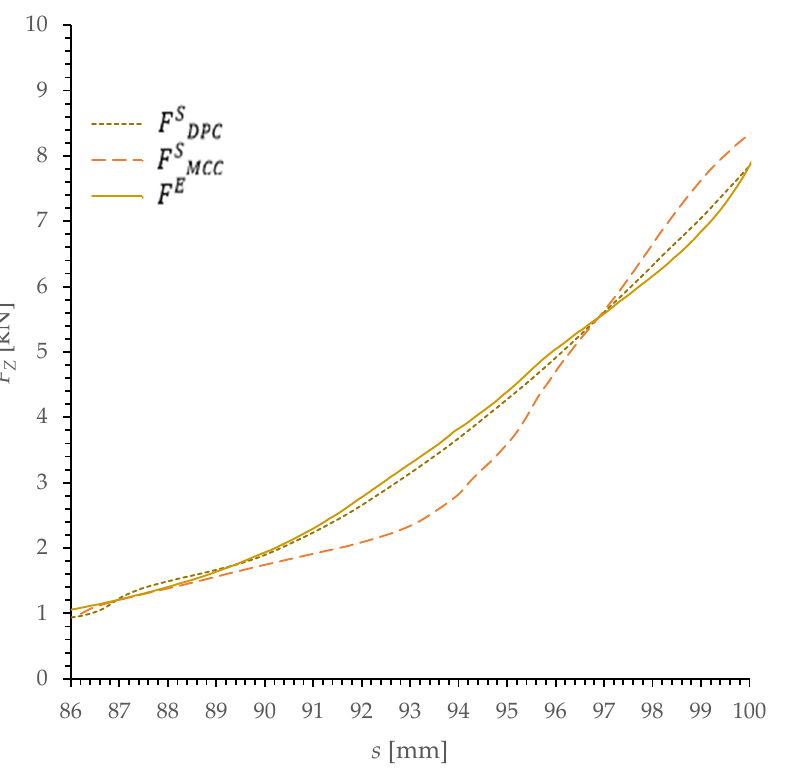
Figure 6. Characteristic of the change of value F Z as a function of s for the empirical test and the simulation results, F S DPC —results of numerical simulation using DPC model; F S MCC —results of numerical simulation using MCC model; F E —results of experimental research. Table 3. SSE